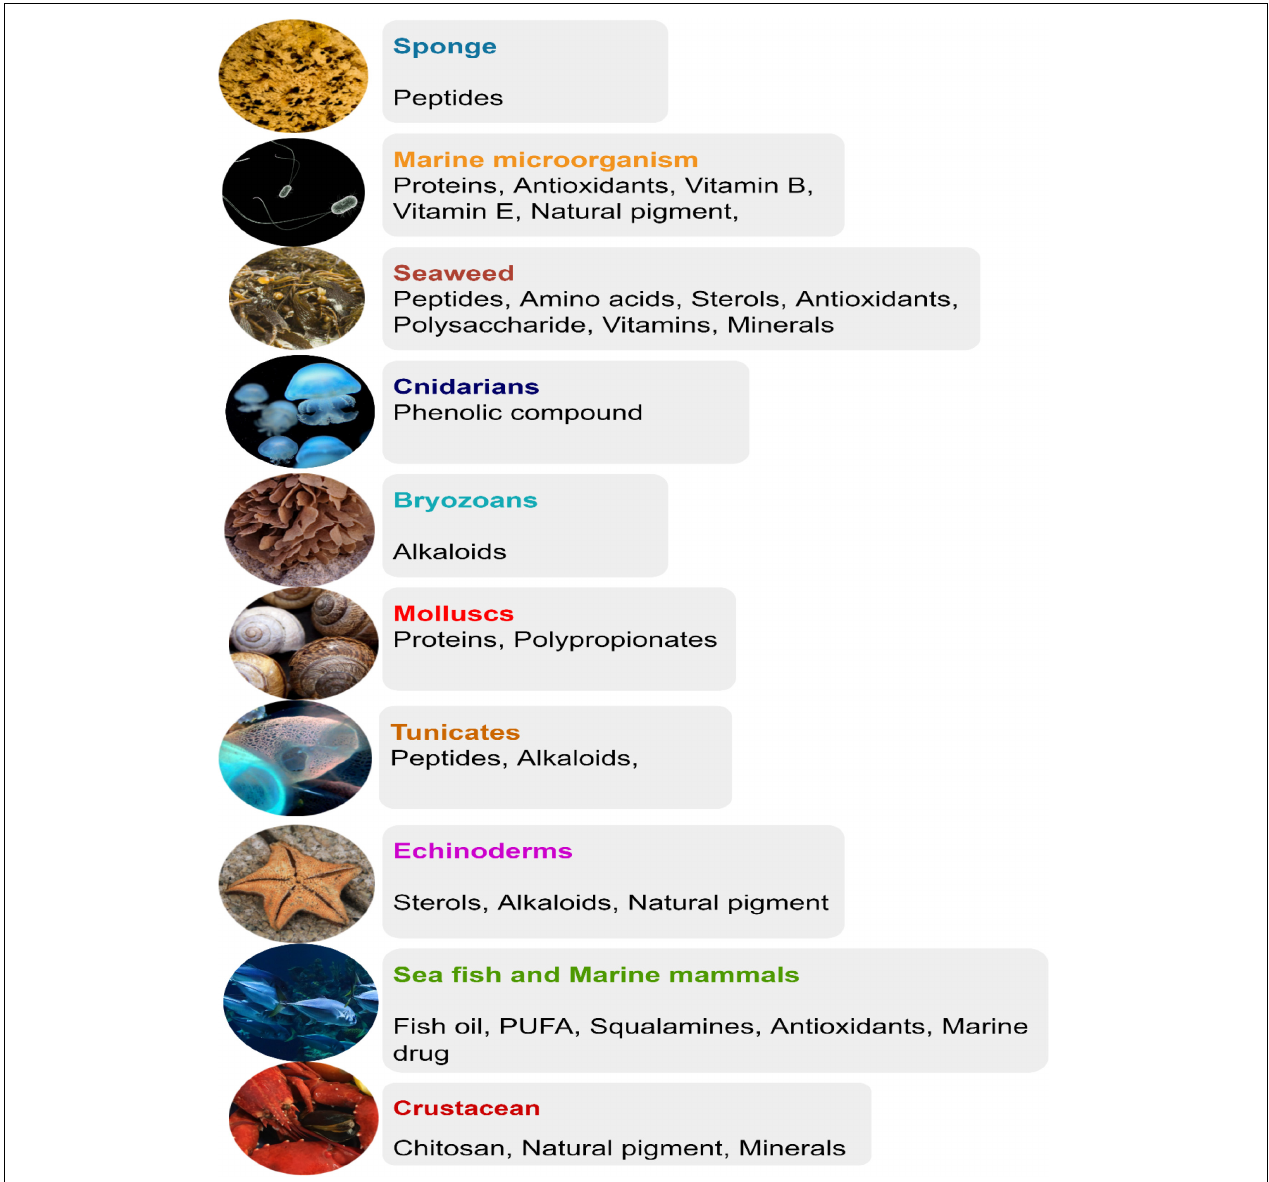
FIGURE 1 | Potential bioactive compounds obtained from different marine